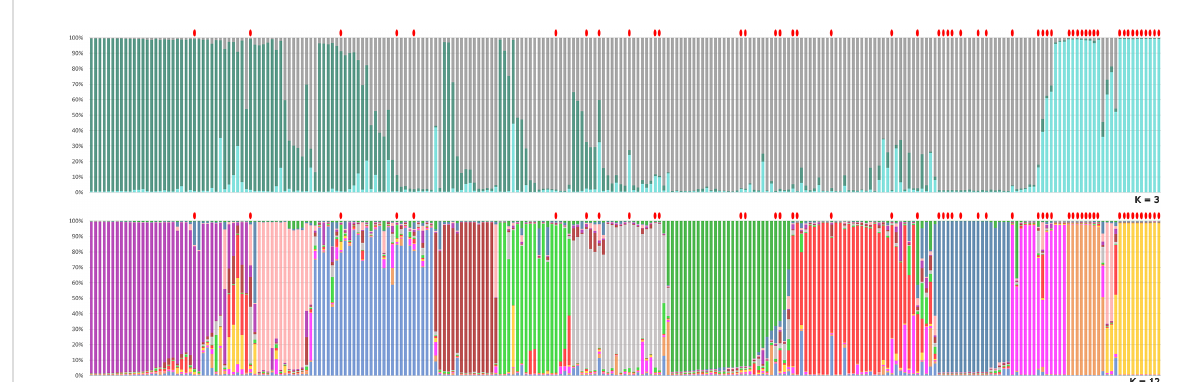
FIGURE 3 Genetic structure of the pear germplasm collection as estimated by STRUCTURE using the SSR marker dataset. Each sample is represented by a vertical-colored histogram partitioned into K = 3 and K = 12 representing the estimated membership. The proportion of ancestry (%) is reported on the abscissa axis. Red dots indicate triploid accessions with two or more loci with a third allele.